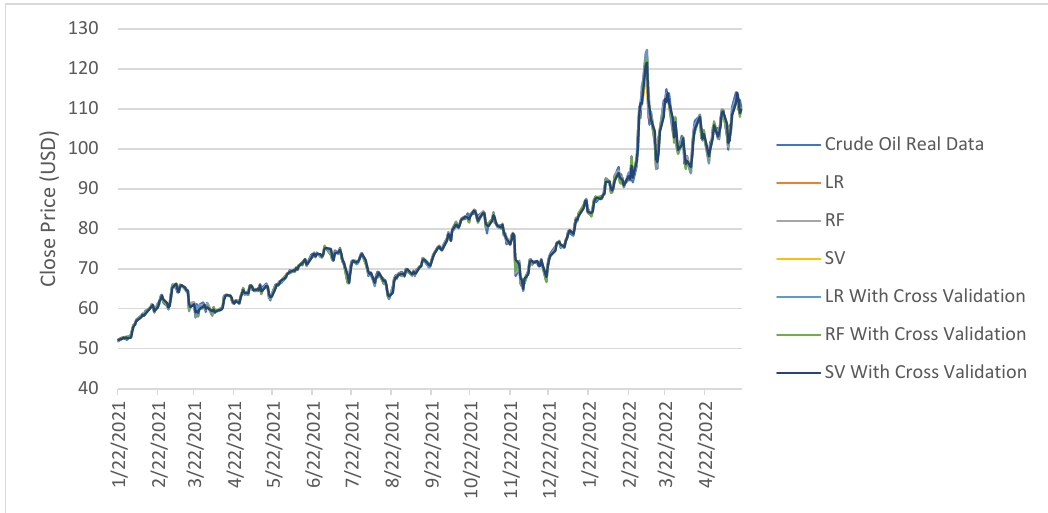
Figure 7. Results for sixteen months with the effect of COVID ‐ 19 for one year.